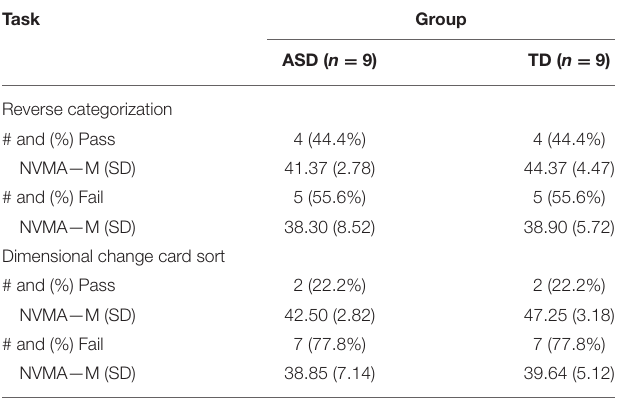
TABLE 4 | Performance of typically developing and autism spectrum disorder groups on the reverse categorization and the dimensional change card sort tasks.